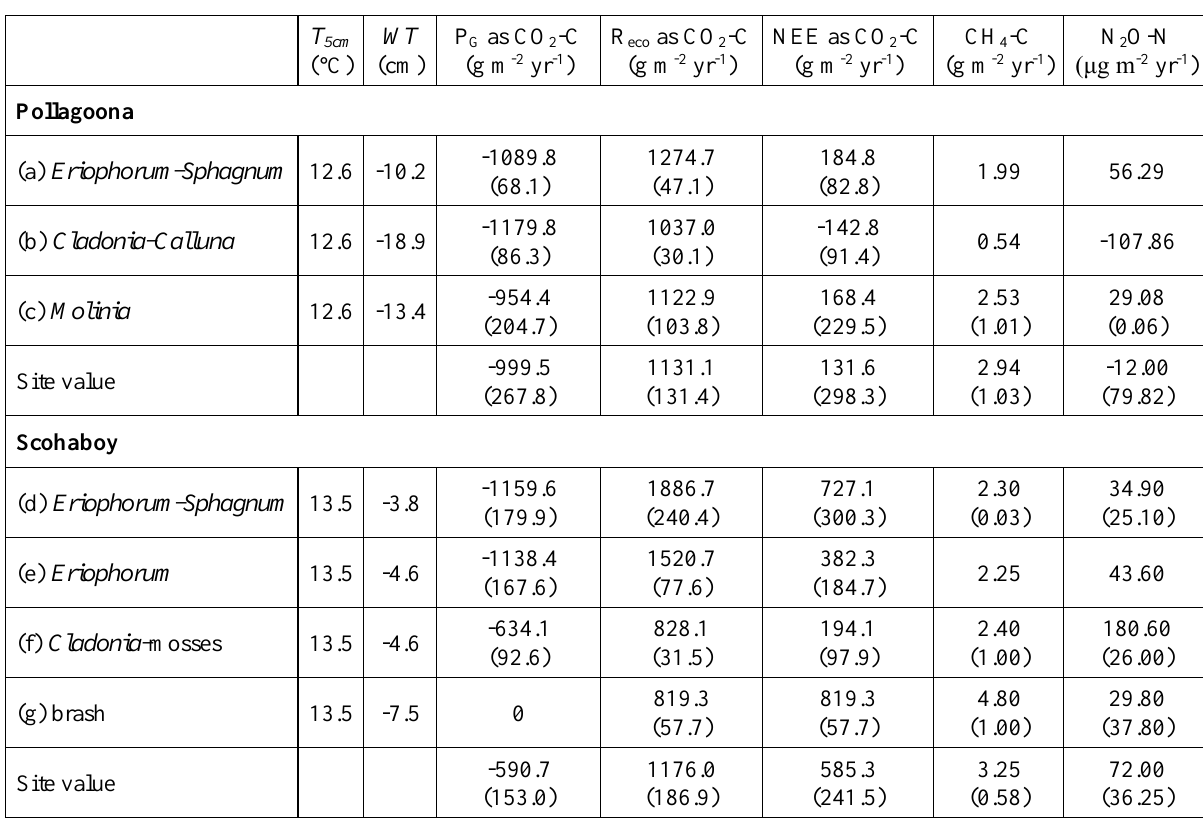
Table 2. Summary of annual sums and averages of greenhouse gases from the Pollagoona sample plots of (a) Eriophorum - Sphagnum , (b) Cladonia-Calluna and (c) Molinia ; and from the Scohaboy sample plots of (d) Eriophorum - Sphagnum , (e) Cladonia -mosses, (f) Eriophorum and (g) brash. Standard errors of estimates for fluxes calculated from more than one sample plot are shown in brackets. Positive values indicate a loss of C from the site and negative values indicate an uptake of C by the site. T depth, WT = water table depth in cm. Standard deviation is not shown for T at site rather than at plot